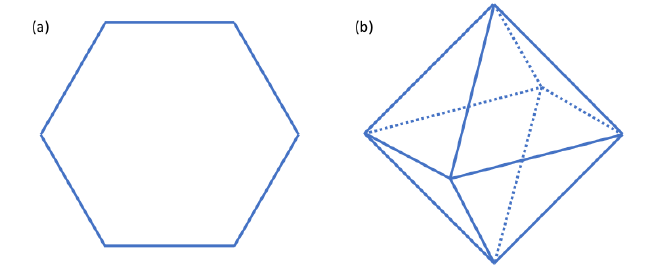
Figure 2. ( a ) A hexagon. The six atoms are located at the six vertices of this hexagon. ( b ) An octahedron. The six atoms are located at the six vertices of this